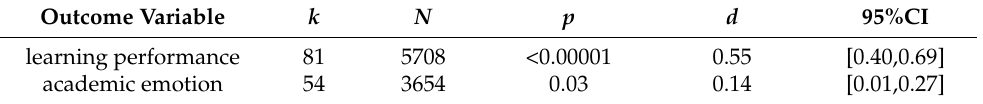
Table 3. Main effects test in intervention studies (random effects